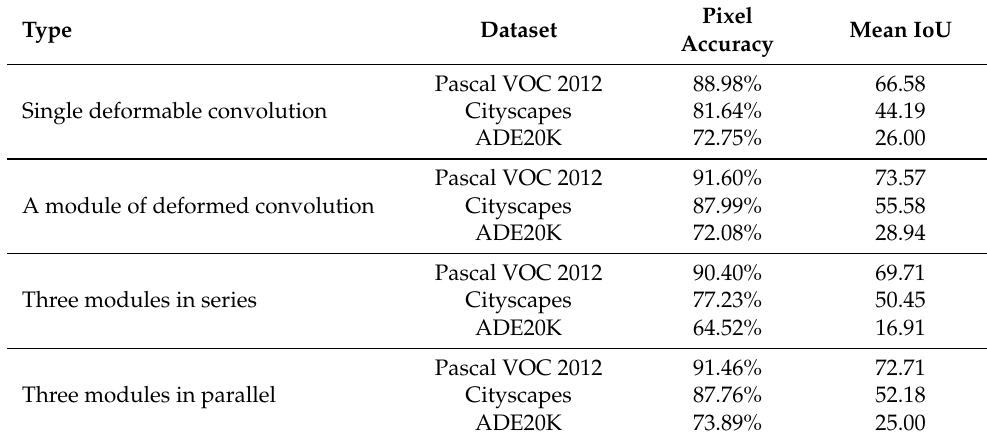
Table 15. Network results on the three datasets after employing the deformable convolutions.